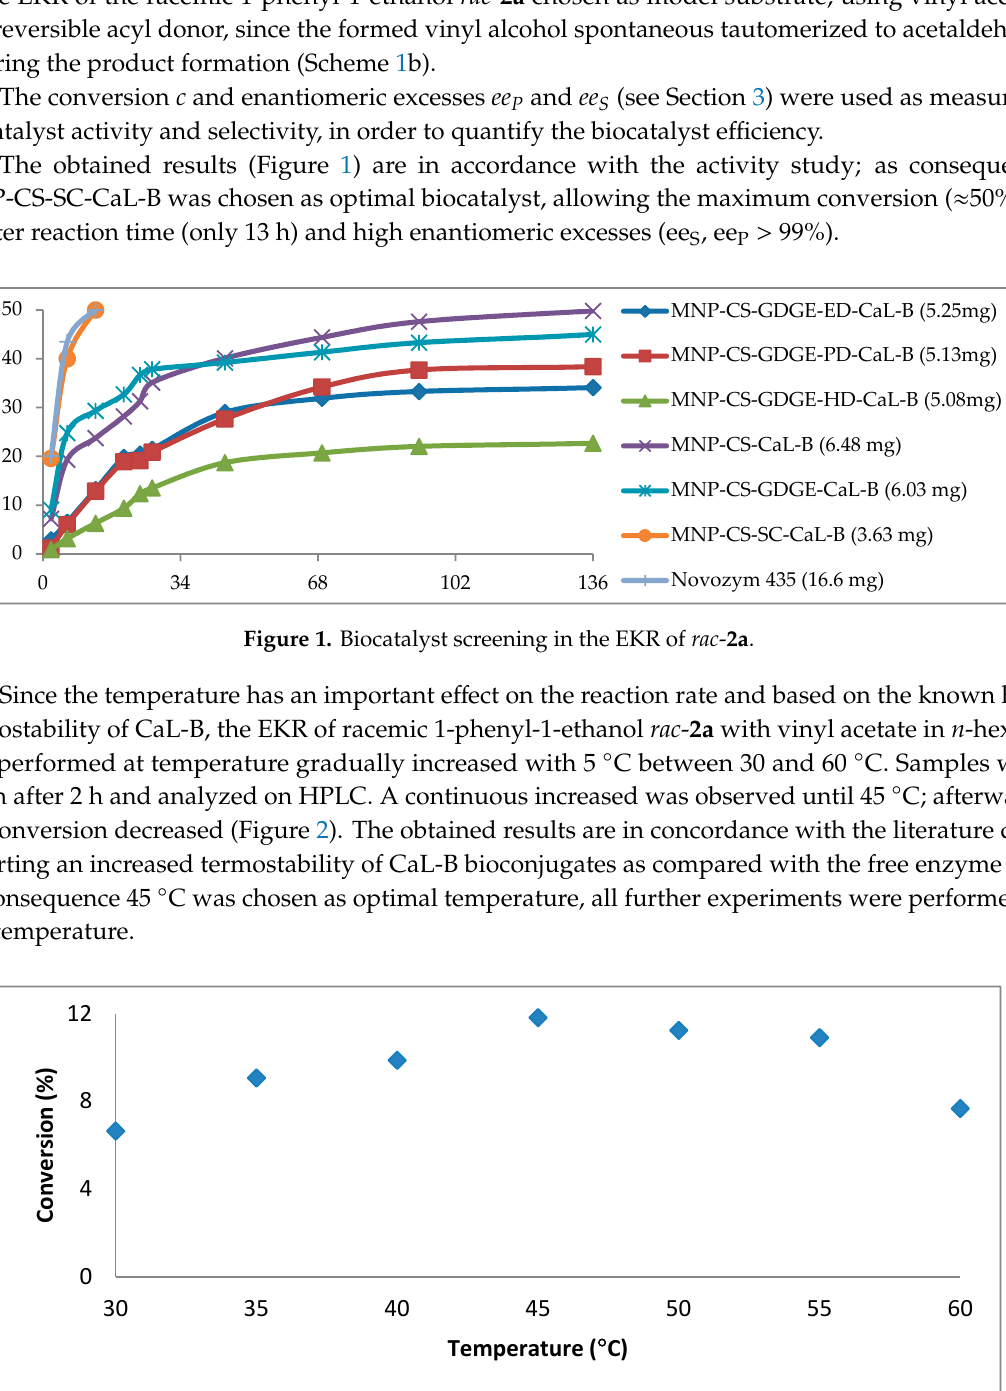
Figure 2. The temperature effect on enzymatic activity of MNP-CS-SC-CaL-B (conversion after two hours).